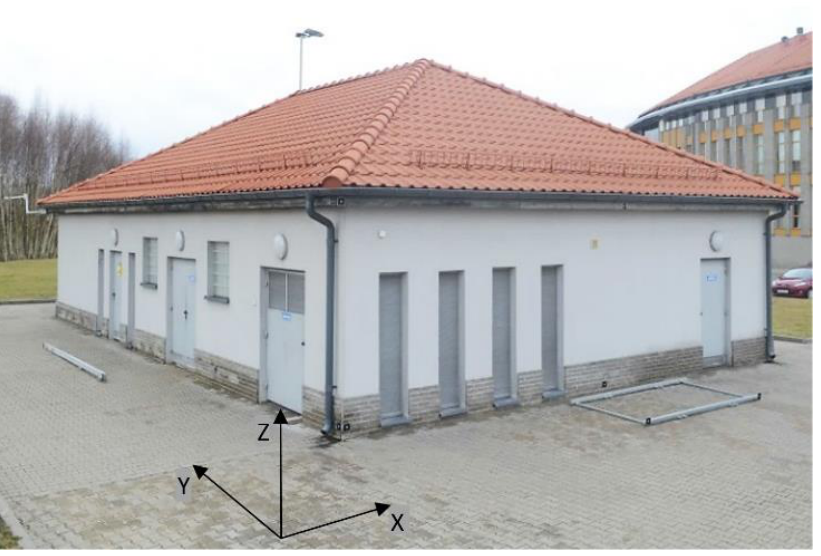
Figure 1. The test object in the defined coordinate system.